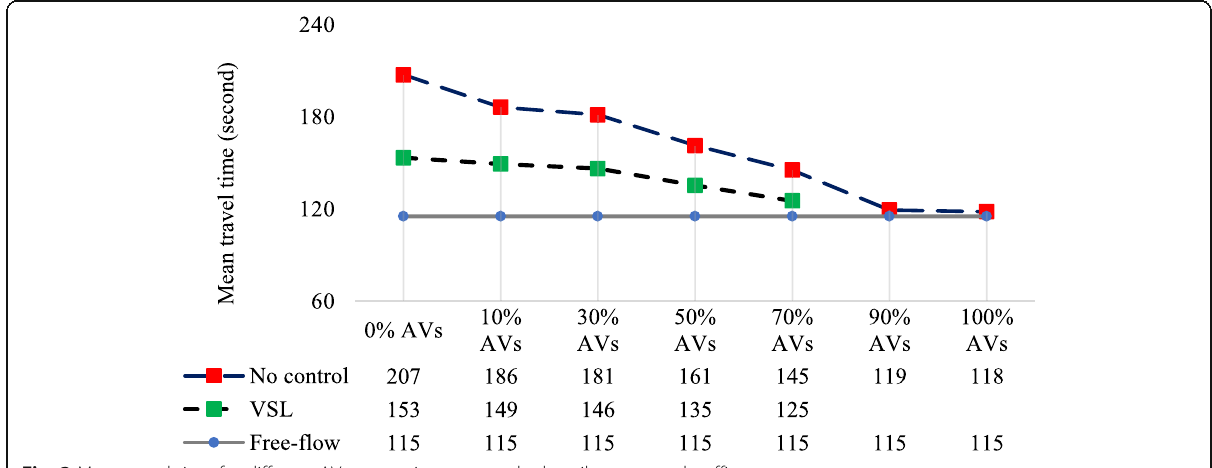
Fig. 3 Mean travel time for different AV penetration rates under heavily congested